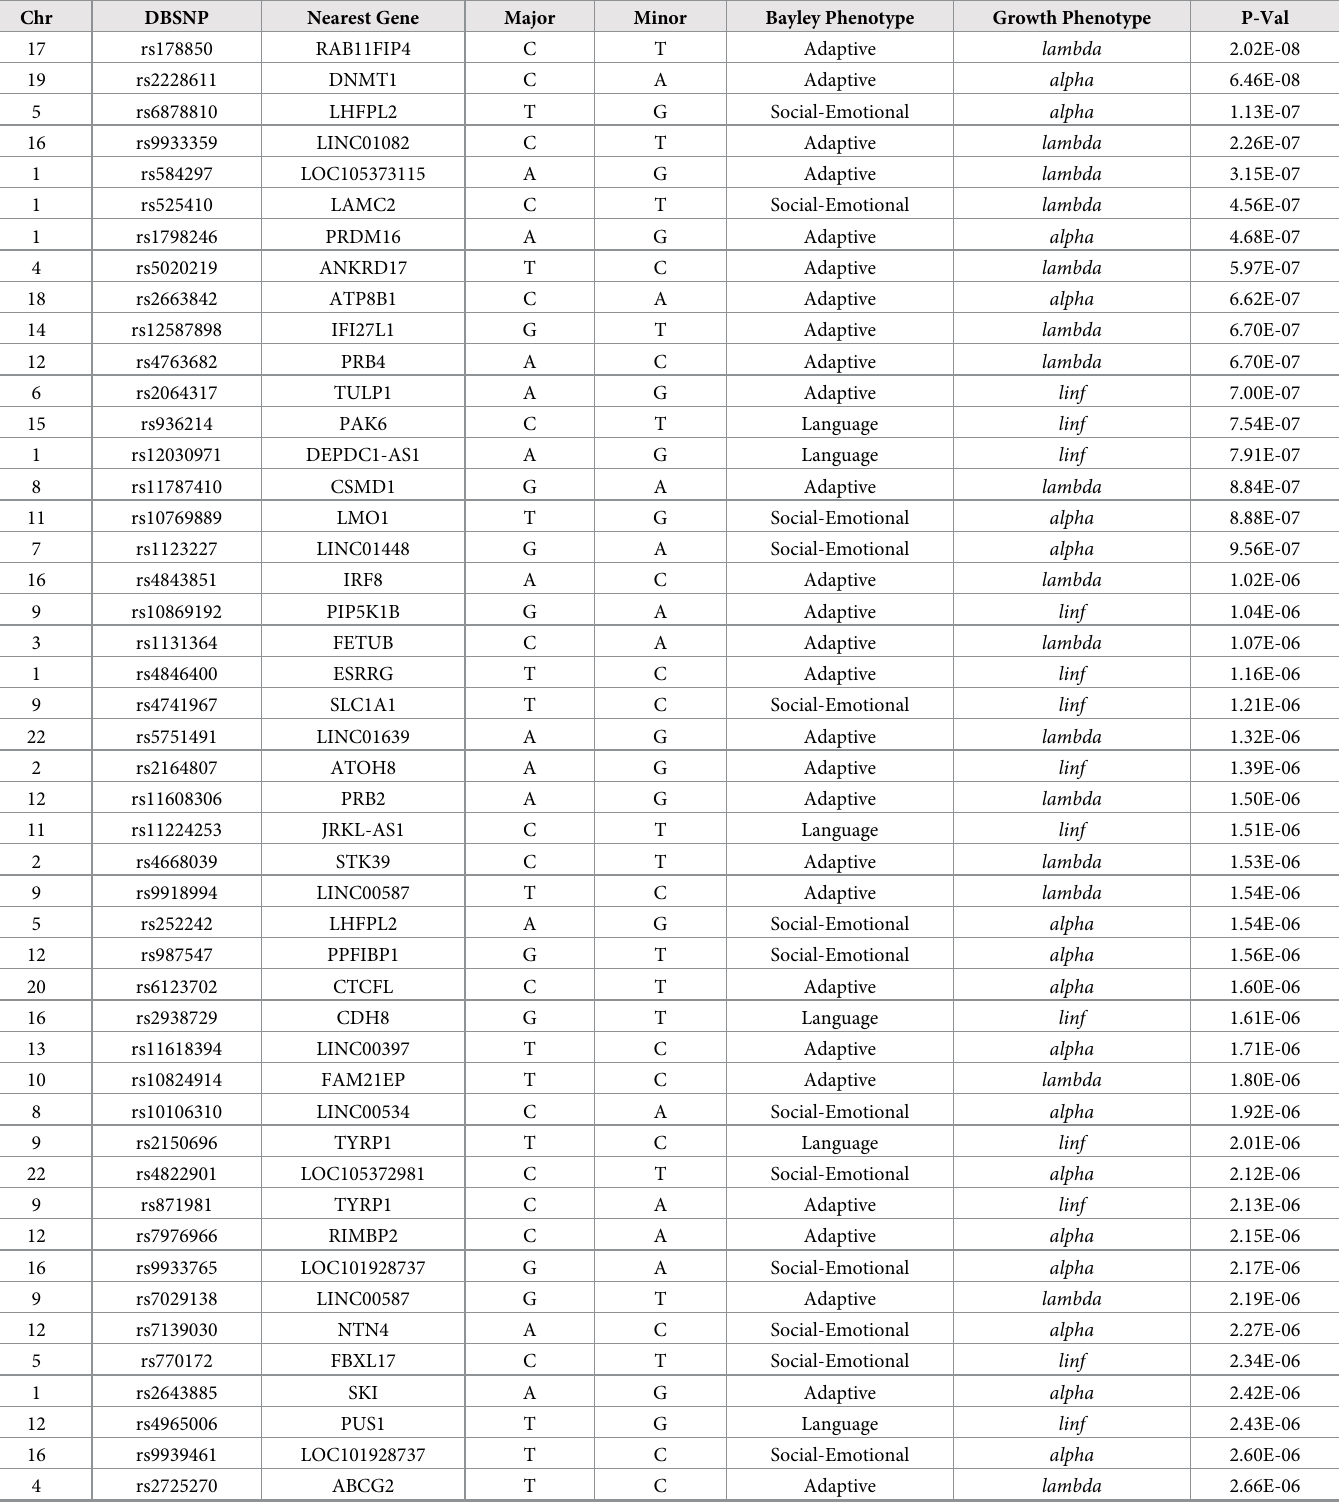
Table 4. Statistically significant pleiotropic SNPs dependent with growth phenotypes ( linf , lambda and alpha ) and Bayley phenotypes using three-way dependency.